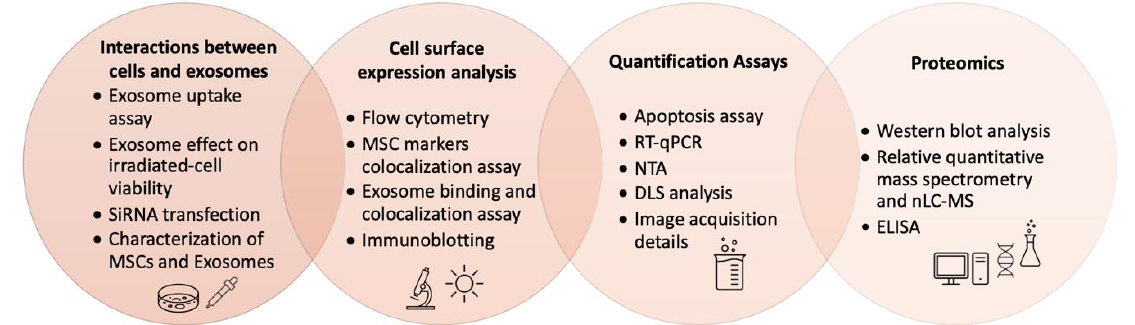
Figure 1. A summary of commonly used methods to characterize exosomes: exosome uptake assay [15], exosome effect on irradiated-cell viability [15], SiRNA transfection [15], immunoblotting [15], cell surface expression analysis (flow cytometry) [15], MSC markers colocalization assay [15], exosome binding and colocalization assay [15–17], image acquisition